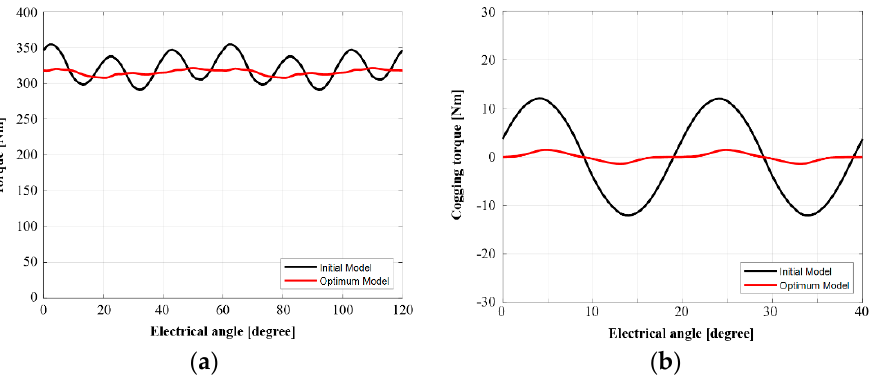
Figure 11. Waveform comparison of the initial model and optimum model: ( a ) Torque waveform; ( b )